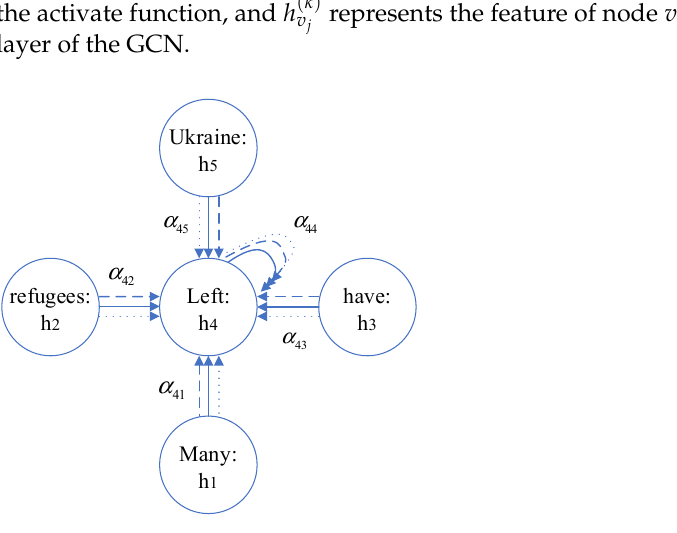
Figure 4. Aggregation of nodes based on the attention mechanism.